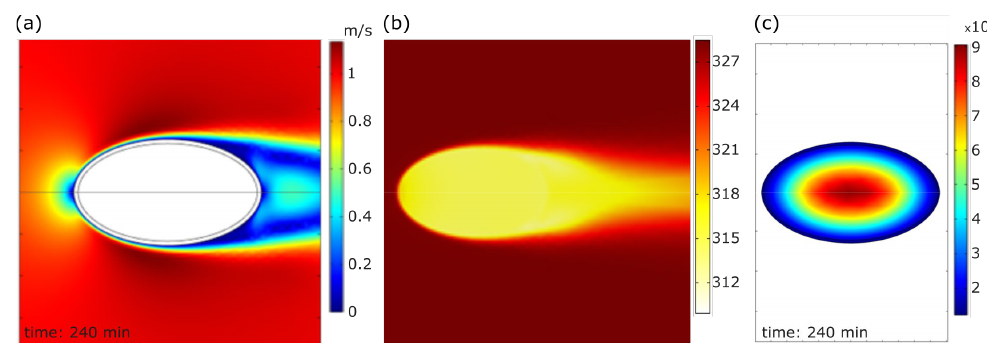
Figure 6. The moisture content dry basis versus the drying time. The quantitative comparison of the numerical results using one solid domain and a multidomain model (shell and core) with the exper- imental results under a constant temperature drying condition of 50 °C.